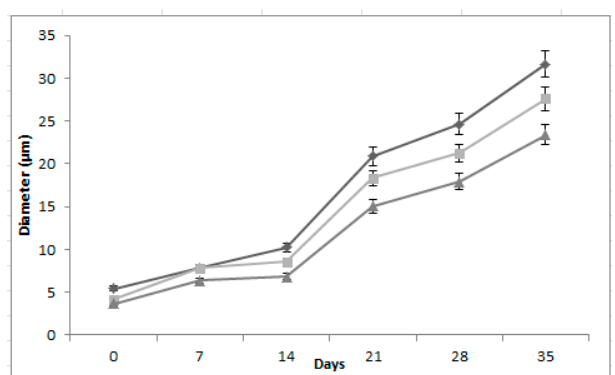
Figure 2. Content of total phenol ( A ), total flavonoids ( B ) and betalains; ( C ) of three multiple emulsions formulated with two polymers, arabic gum (GA) and maltodextrin (MD): AG40%-MD60% AG50%-MD50% and AG60%-MD40% during 36 days of storage.